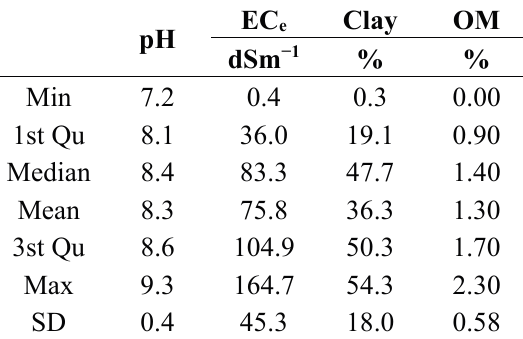
Table 2. Descriptive statistics of the soil parameters. EC, electrical conductivity; OM, organic